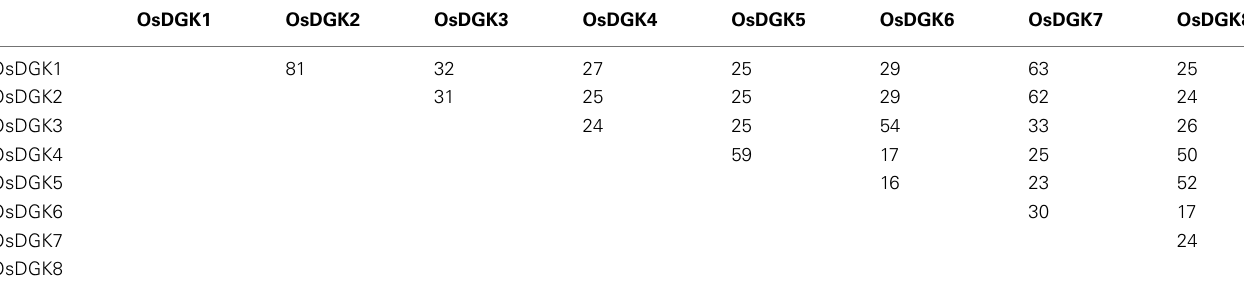
TableA5 |Amino acid sequence identities among